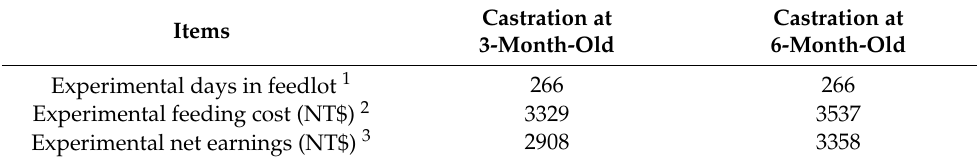
Table 6. The economic analysis of castration at different ages for Nubian crossbred male goats.